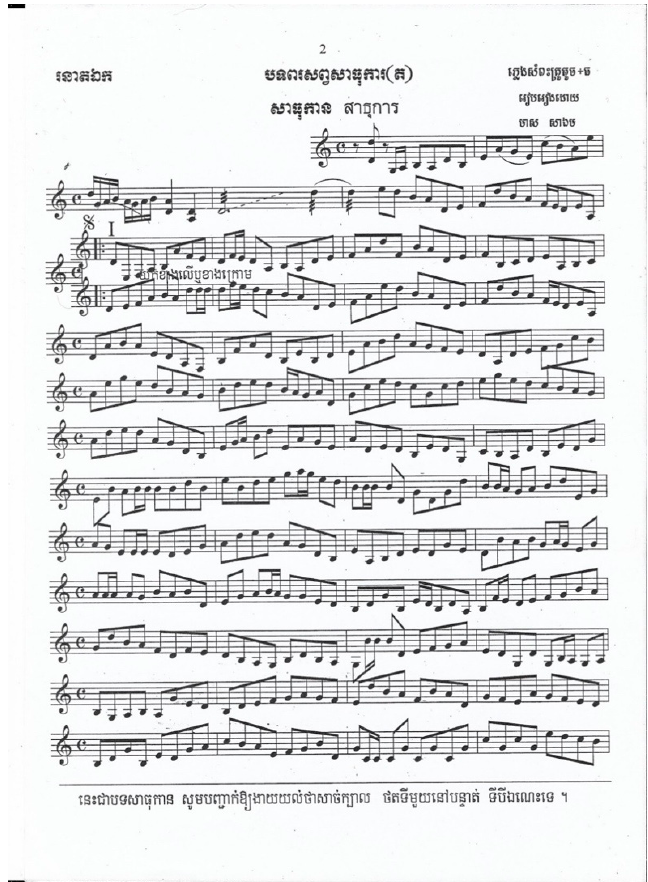
Figure 3. “S ā dhuk ā r” by Meas Sa Em: The first page of Meas Sa Em’s notated version of the song Figure 3. “S¯adhuk¯ar” by Meas Sa Em: The first page of Meas Sa Em’s notated version of the song “S ā dhuk ā r”, for which he combined variations he learned from several different teachers. “S¯adhuk¯ar”, for which he combined variations he learned from several di ff erent